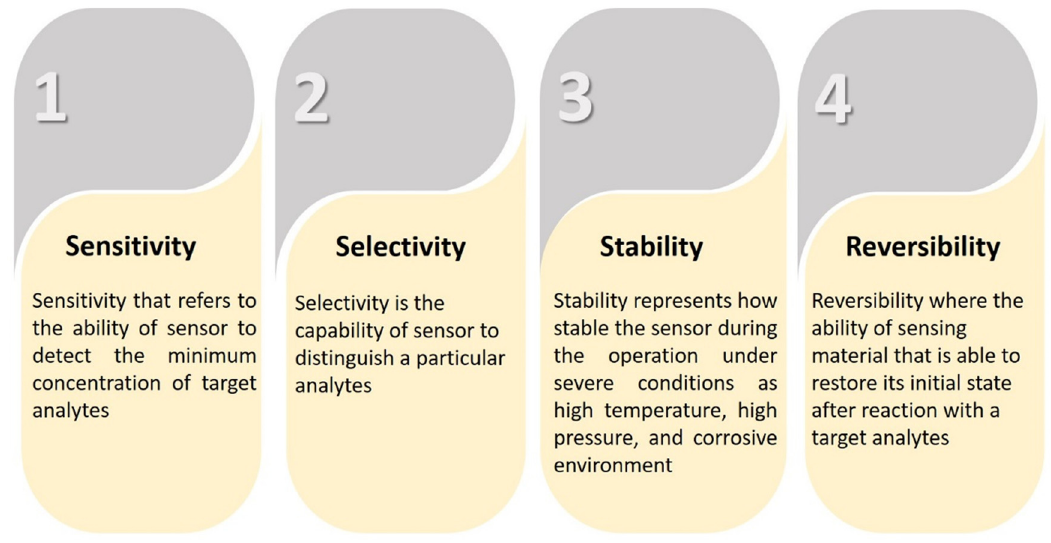
Figure 6: Four major important aspects for chemical